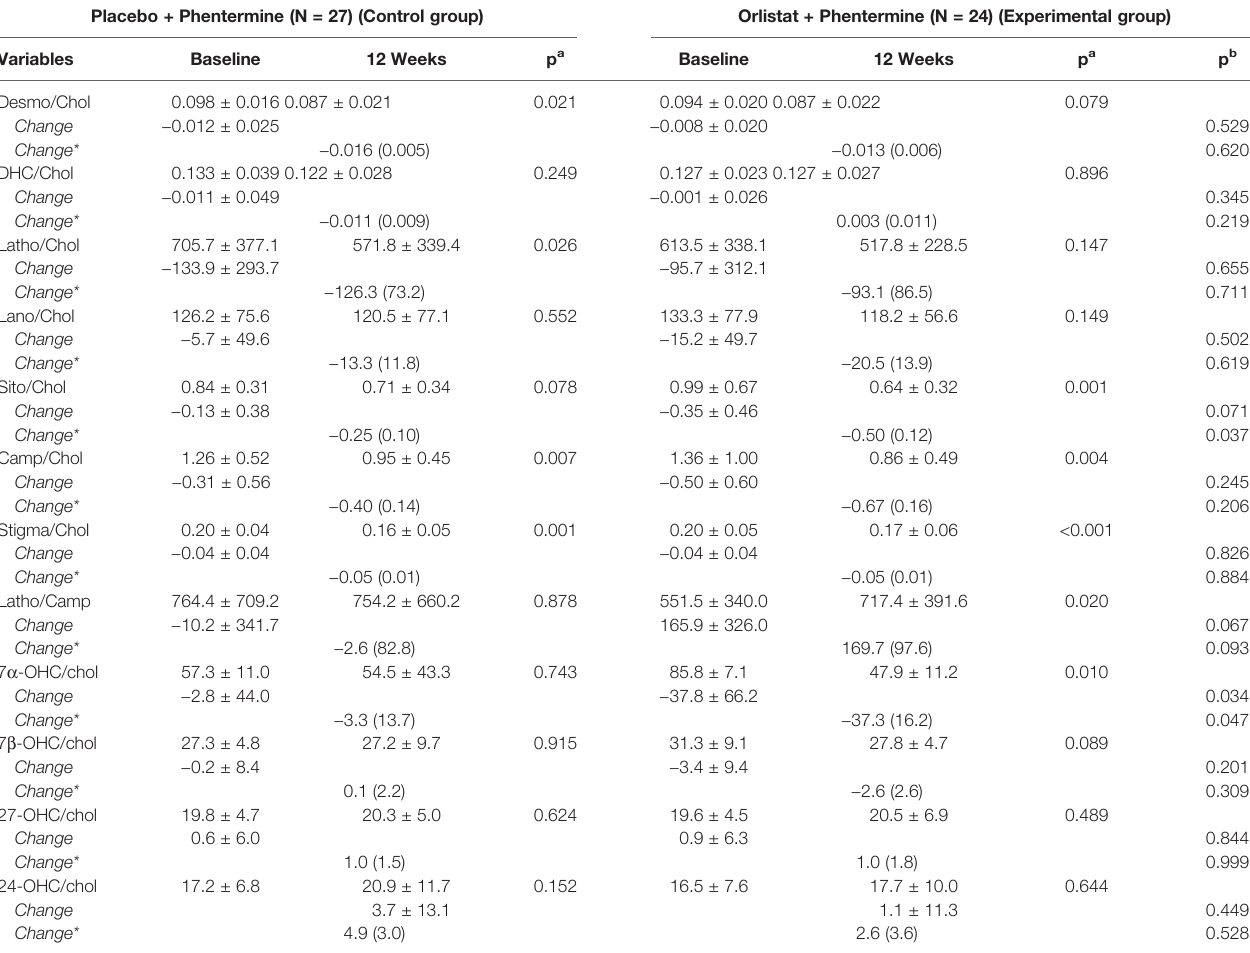
TABLE 3 | Changes in metabolic ratio of the sterols in overweight or obese participants treated with placebo plus phentermine or orlistat plus phentermine for 12 weeks. Placebo + Phentermine (N = 27) (Control group) Orlistat + Phentermine (N = 24) (Experimental